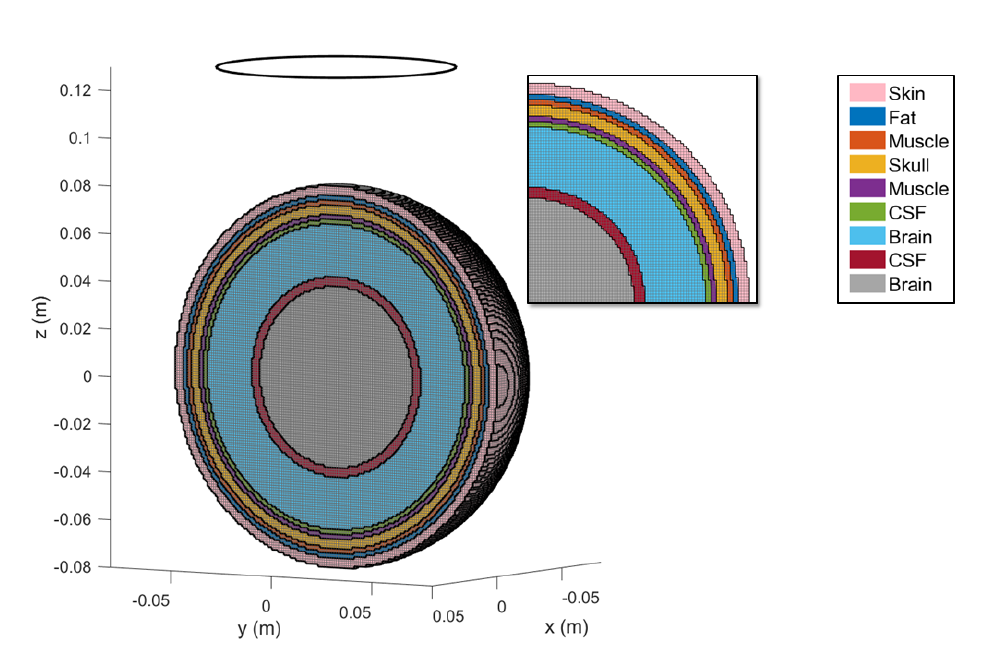
Figure 3. Multilayered sphere. The various layers are highlighted by different colors. In the inset the stair-casing effect due to the voxel-discretization is displayed. The source field is created by a coil with a 5 cm radius and located 13 cm above the center of sphere.